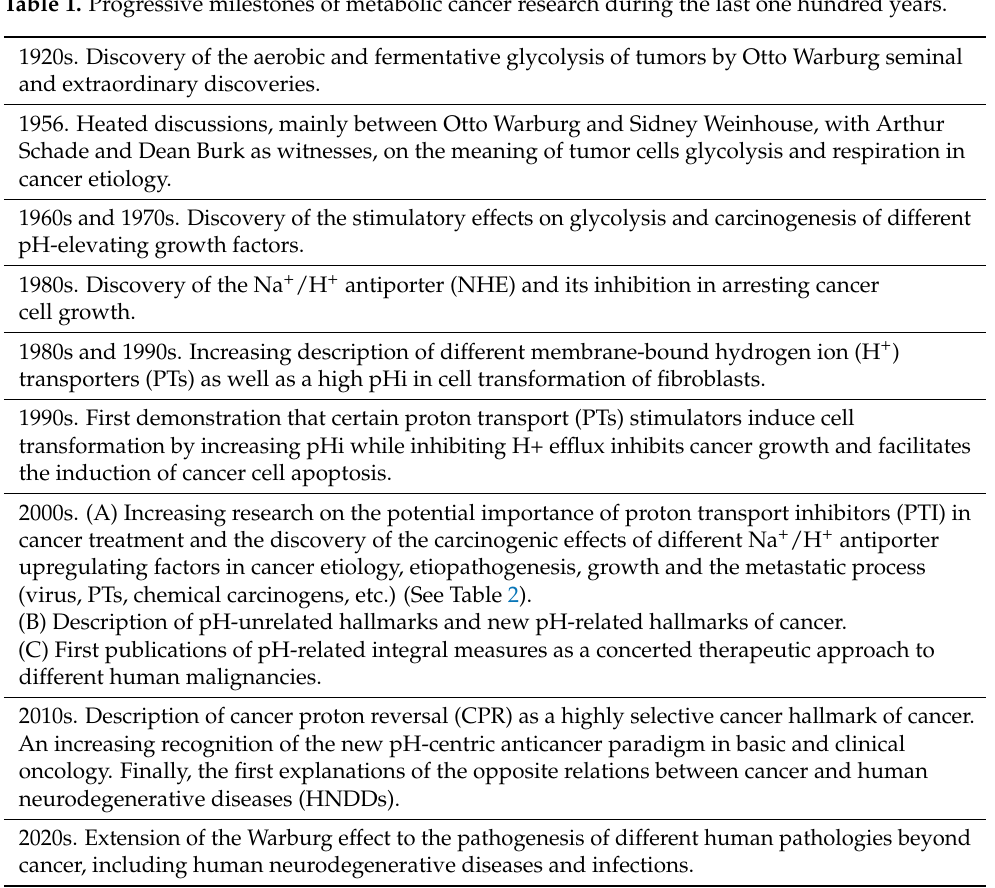
Table 1. Progressive milestones of metabolic cancer research during the last one hundred years.